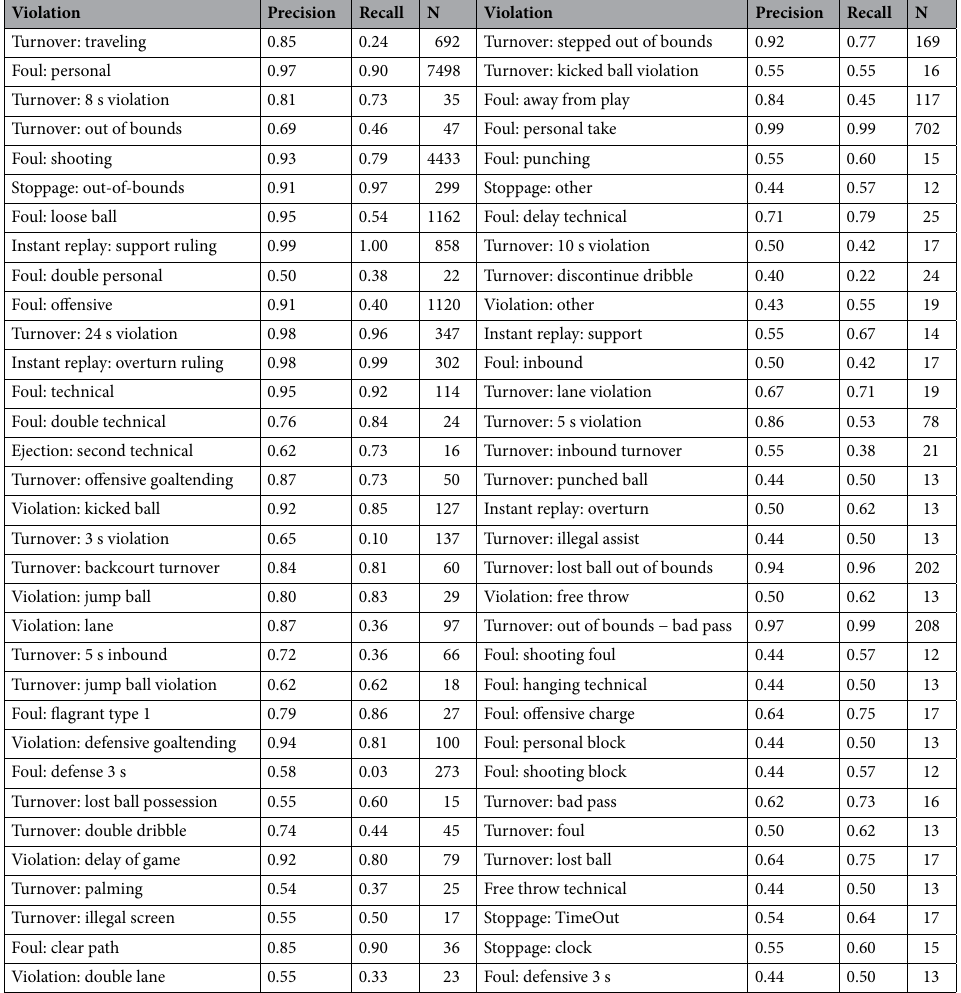
Table 1. Precision and recall of different types of